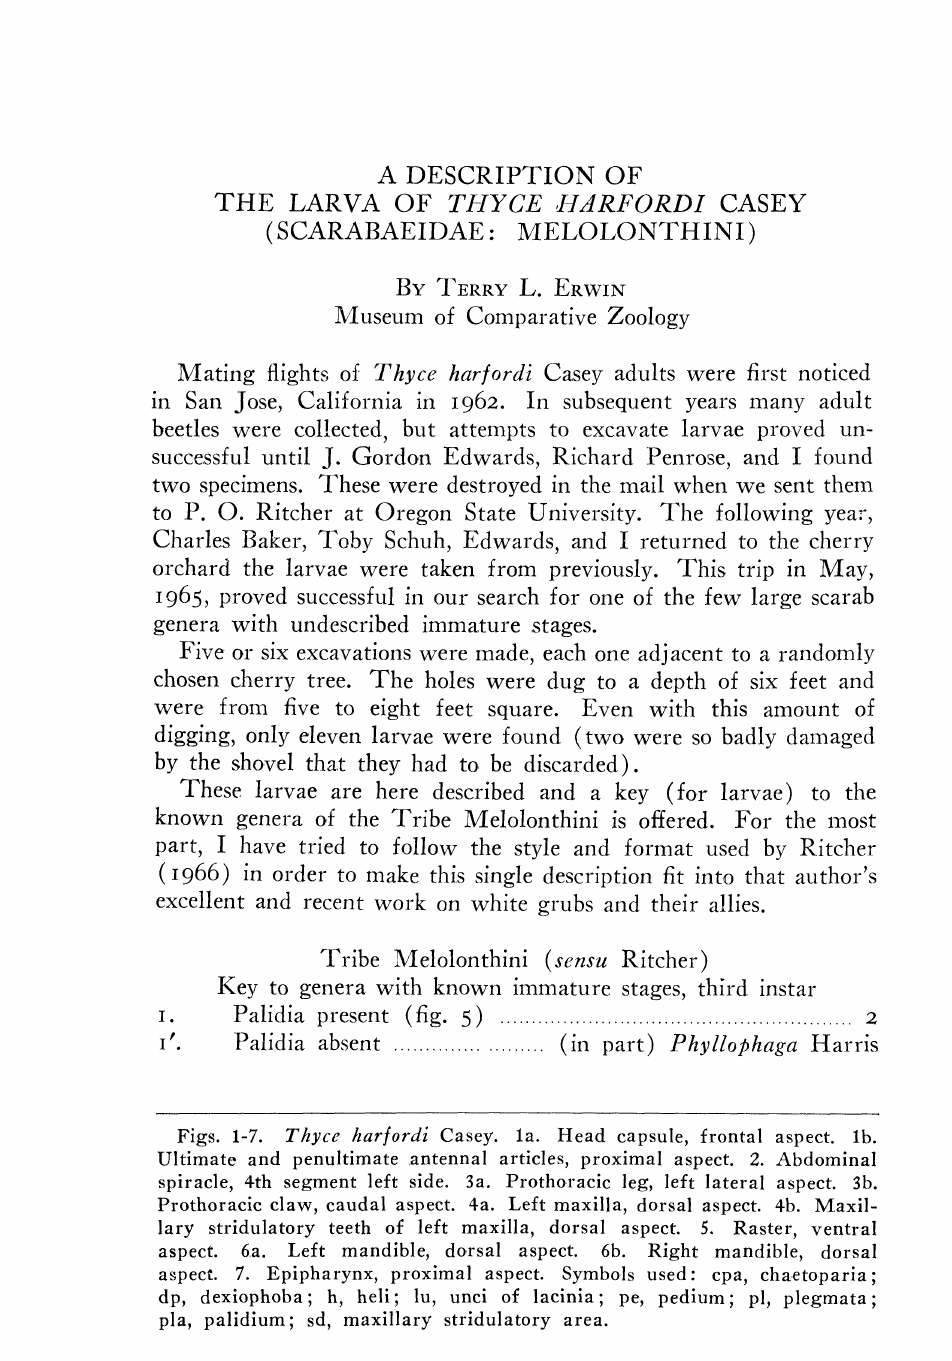
Figs. 1-7. Thyce harfordi Casey. la. Head capsule, frontal aspect, lb. Ultimate and penultimate antennal articles, proximal aspect. 2. Abdominal spiracle, 4th segment left side. 3a. Prothoraeie leg, left lateral aspect. 3b. Prothoraeie claw, caudal aspect. 4a. Left maxilla, dorsal aspect. 4b. Maxil- lary stridulatory teeth of left maxilla, dorsal aspect. 5. Raster, ventral aspect. 6a. Left mandible, dorsal aspect. 6b. Right mandible, dorsal aspect. 7. Epipharynx, proximal aspect. Symbols used: epa, eha.etoparia; dp, dexiophoba; h, hell; lu, unei of laeinia; pc, pedium; pl, plegmata; pla, palidium; sd, maxillary stridulatory